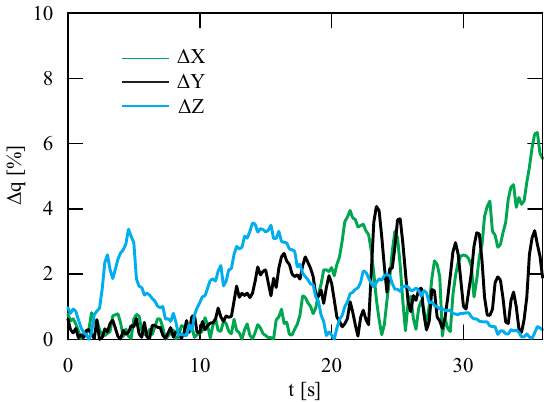
Figure 18. Percentage error of the generalized coordinates obtained during simulation and experi- mental